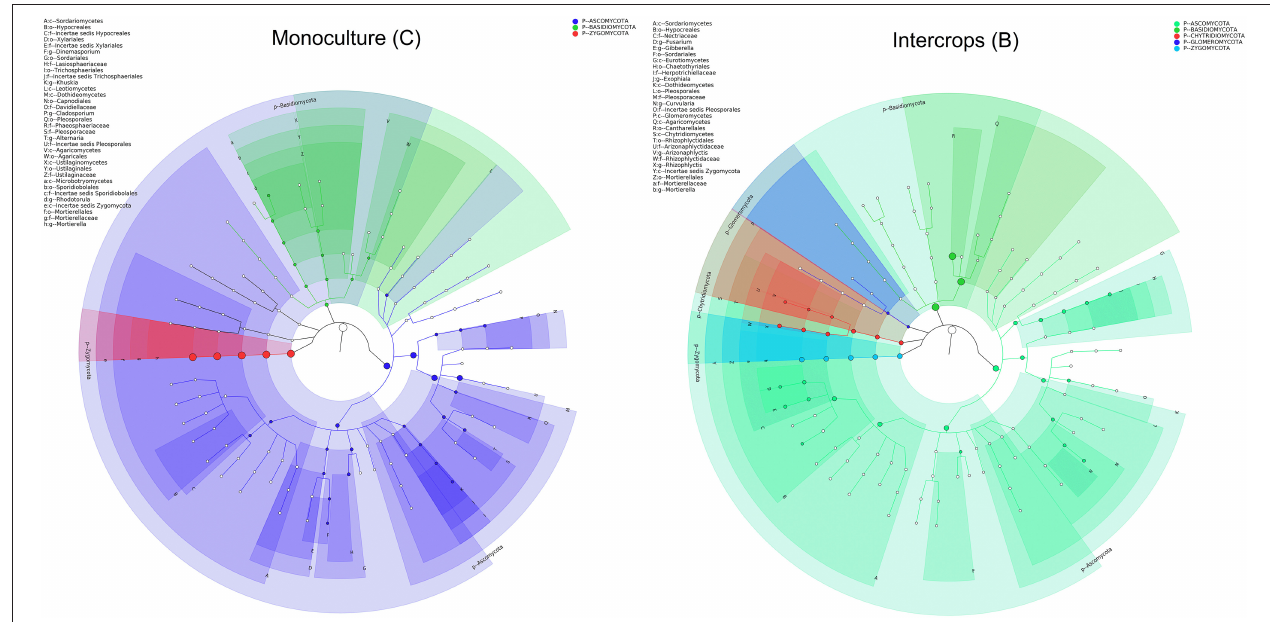
FIGURE 4 | Species annotation of 16S rRNA groups presented in conjunction with the GRAPhlAn. The circles in the graph represent different classification levels from the inside out, the different colors represent different phylum, and the top 40 species in abundance are represented by solid circles. B: Intercrop, C: Monoculture.